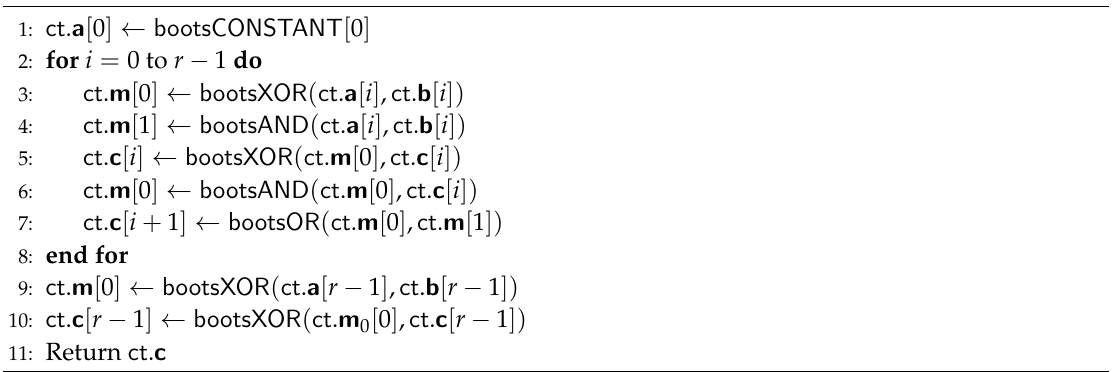
Algorithm 4 HomAdd ( ct . a , ct . b , r ): Homomorphic addition for matrix